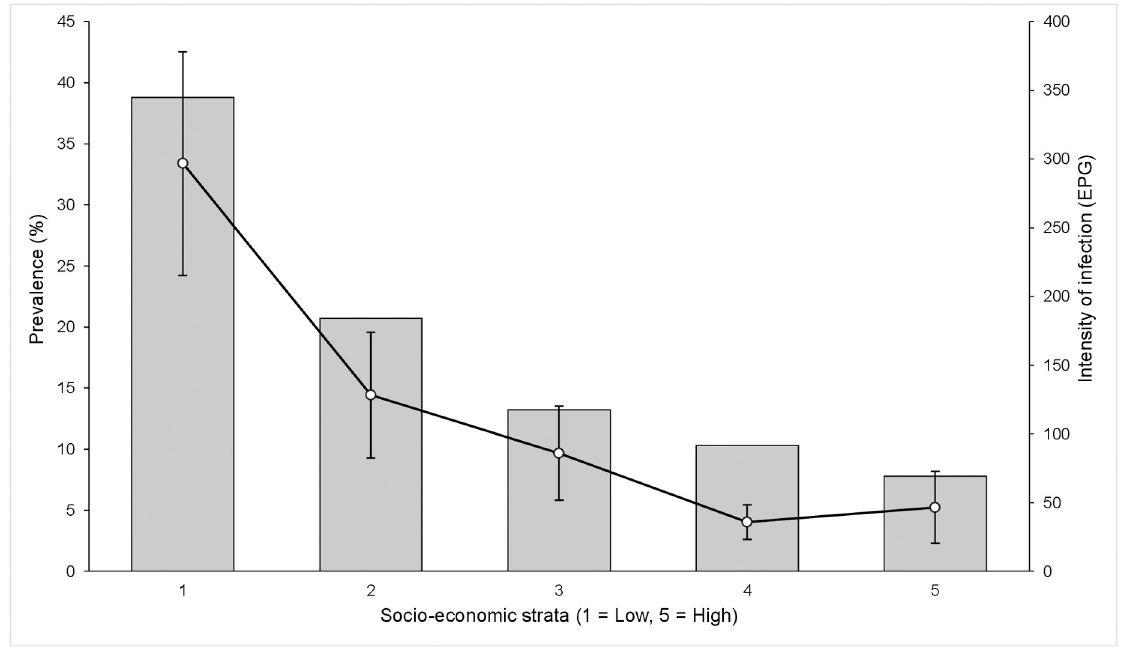
Fig 4. Prevalence and intensity of hookworm among surveyed participants stratified by categories of socio-economic status—prevalence (bars) and intensity (lines).